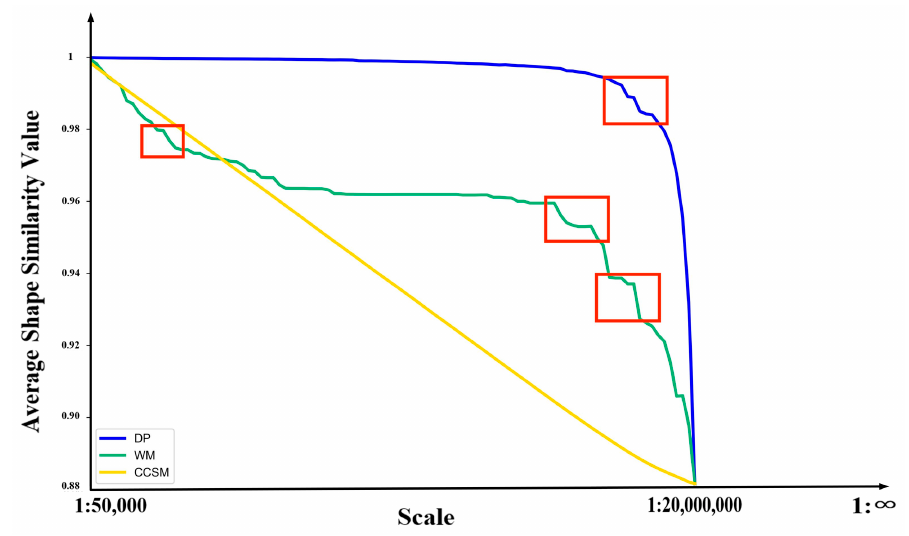
Figure 10. Average shape similarity trend of three simplification methods. Overall, the average shape similarity value decreased along with the scale for all three simplification methods. As shown in Figure 10, both the blue and green curves jumped (denoted by red rectangles), which means that the shapes of the simplified contour lines generated by the DP and WM algorithms were not continuously changing. In other words, as the scale gradually changed, the changes in the shape of the simplified contours generated by the DP and WM algorithms were not continuous but abrupt, thereby leading to the loss of some intermediate scale details. In this case, the user demand for visual continuity is left unsatisfied. By contrast, the yellow curve in Figure 10 representing CCSM shows a monotonic and continuous trend that closely reflects the ideal relationship between similarity and scale at a continuous multi-scale (Figure 7). The average shape similarity gradually decreased along with the scale. Therefore, CCSM can obtain smooth and continuous multi-scale simplified